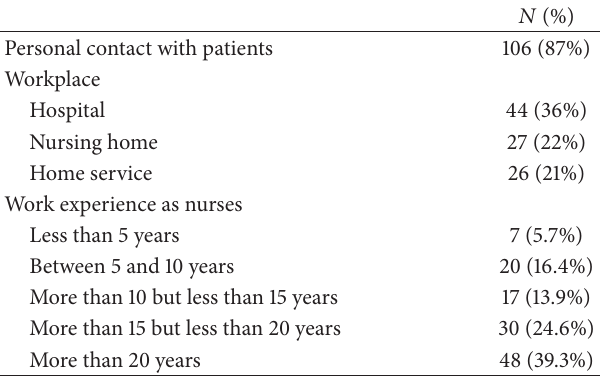
Table 1: Information about participants’ workplace, years since graduation, and years of work experience as nurses.